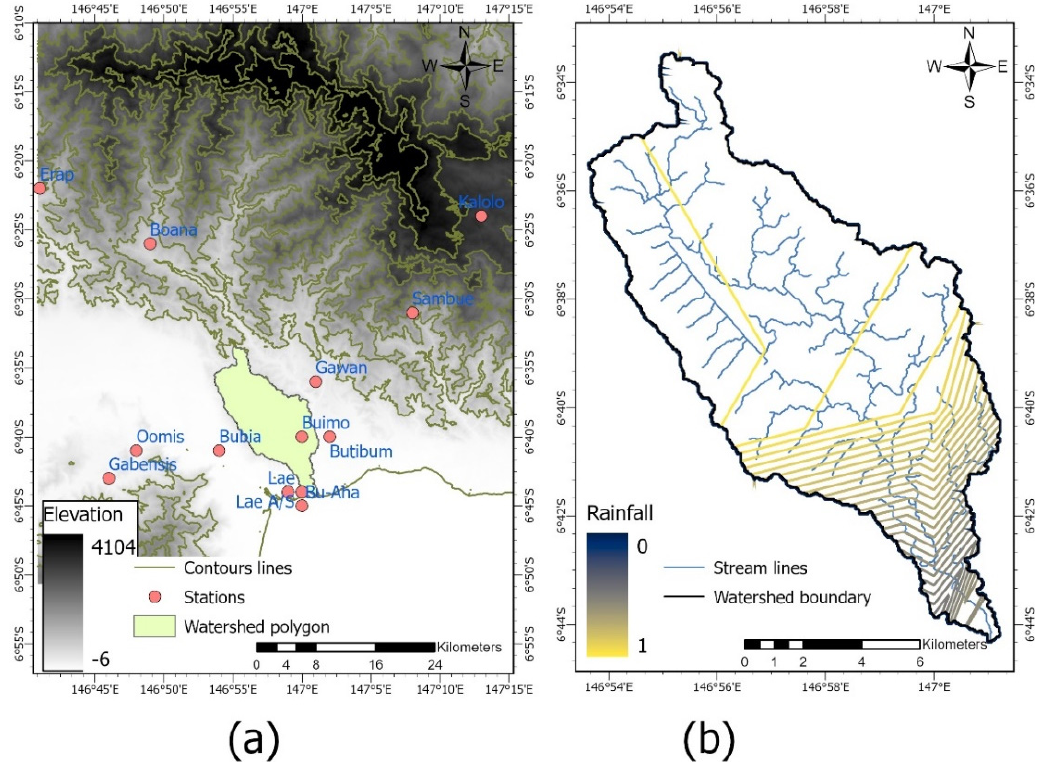
Figure 8. Rainfall analysis data sites and results: ( a ) 13 weather station locations from McAlpine (1975) used to model average annual rainfall pattern across the Bumbu Watershed and ( b ) average annual rainfall contours as estimated by Triangulated Irregular Network (TIN) scaled 1 to 100% of